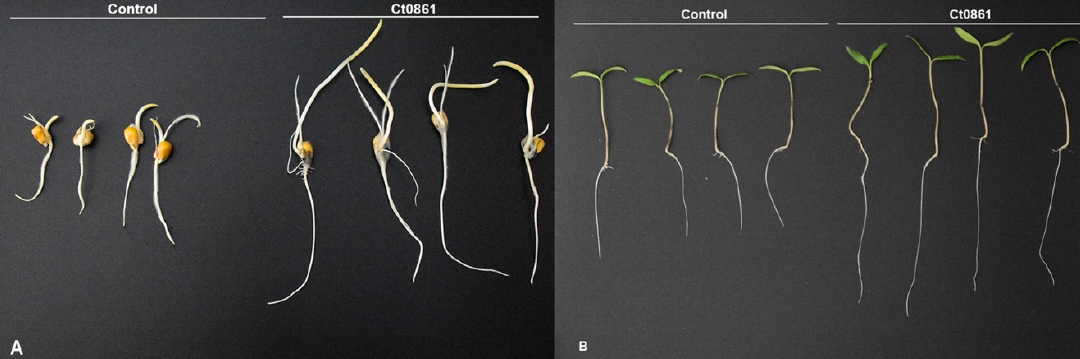
Figure 1. Representative image of maize ( A ) and tomato ( B ) seedlings from seeds inoculated with Ct0861 or water for control and grown in ½ MS medium for six days. Maize seeds were inoculated at a dose of 10 3 conidia·seed − 1 and grown in darkness at 24 °C. Tomato seeds were inoculated at a dose of 10 4 conidia·seed − 1 and cultivated vertically at 24 °C with a photoperiod of 14 h of light and 10 h of darkness.